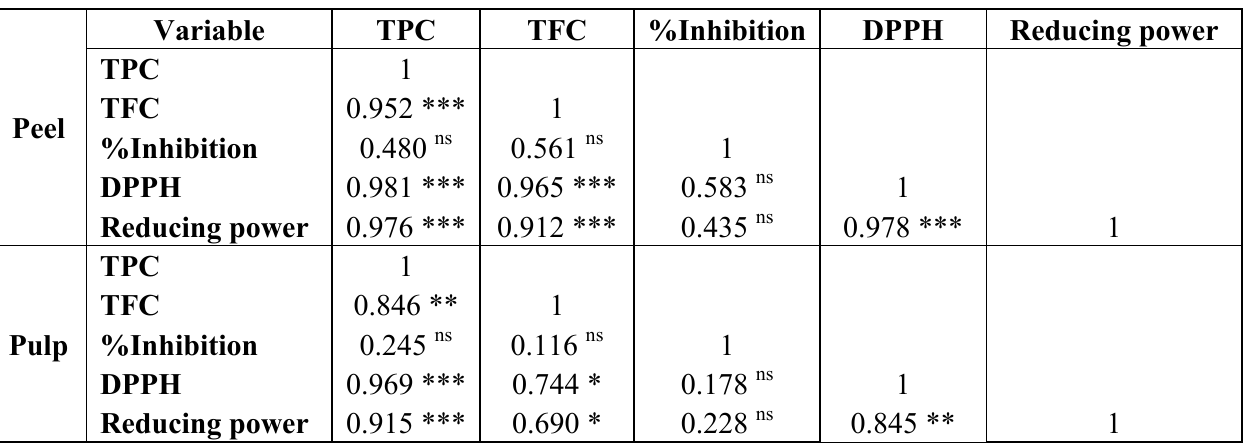
Table 4 Comparison of results from different antioxidant assays as represented by correlation coefficient ( r